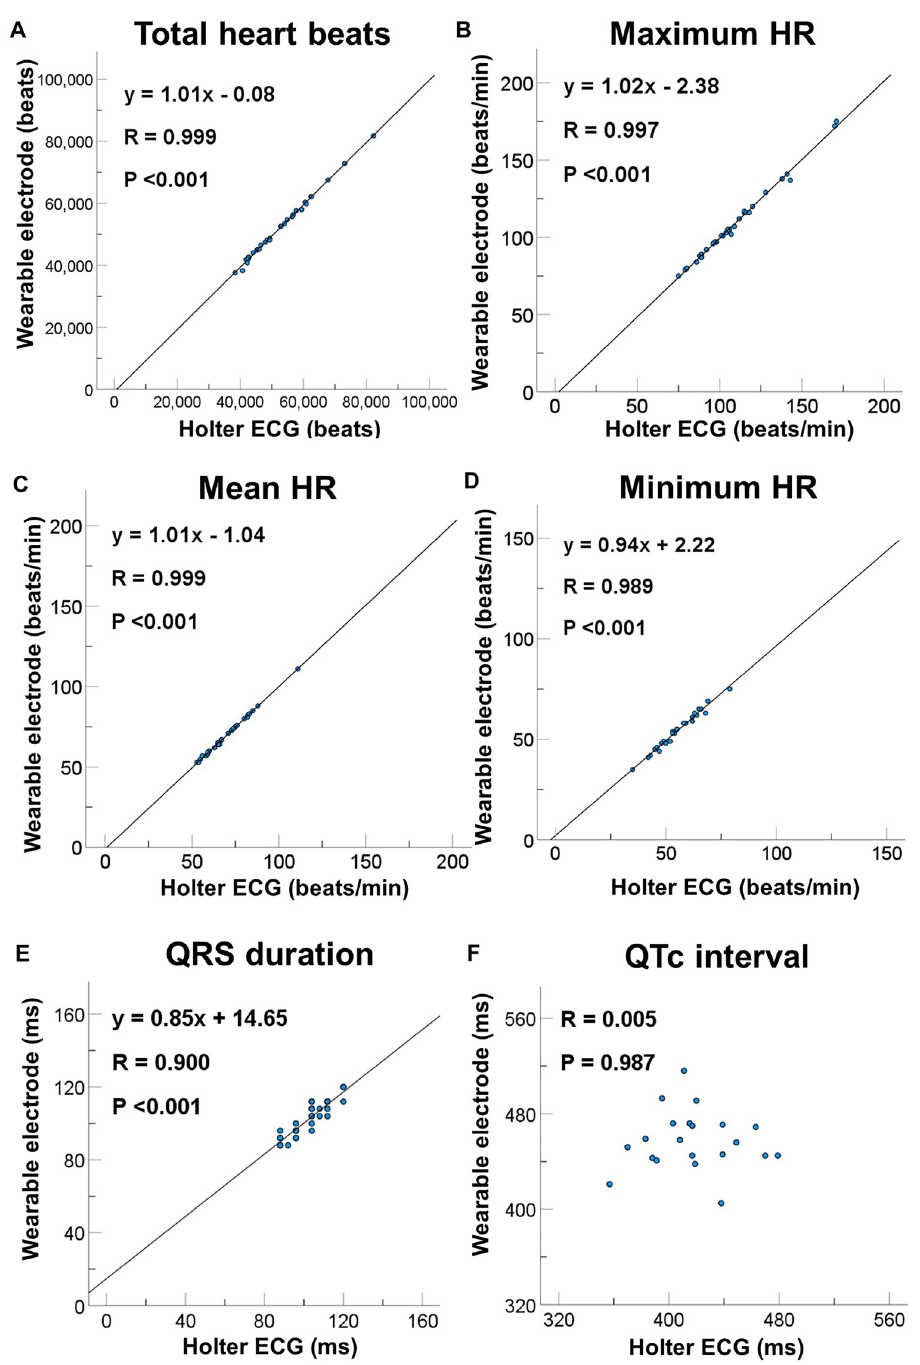
Fig 2. Regression analysis of each parameter measured by wearable electrodes embedded in undershirts and Holter ECG. (A) Regression analysis of total heart beats, (B) maximum HR, (C) mean HR, (D) minimum HR, (E) QRS duration and (F) QTc interval measured by two methods. Abbreviations: HR, heart rate; ECG, electrocardiogram.